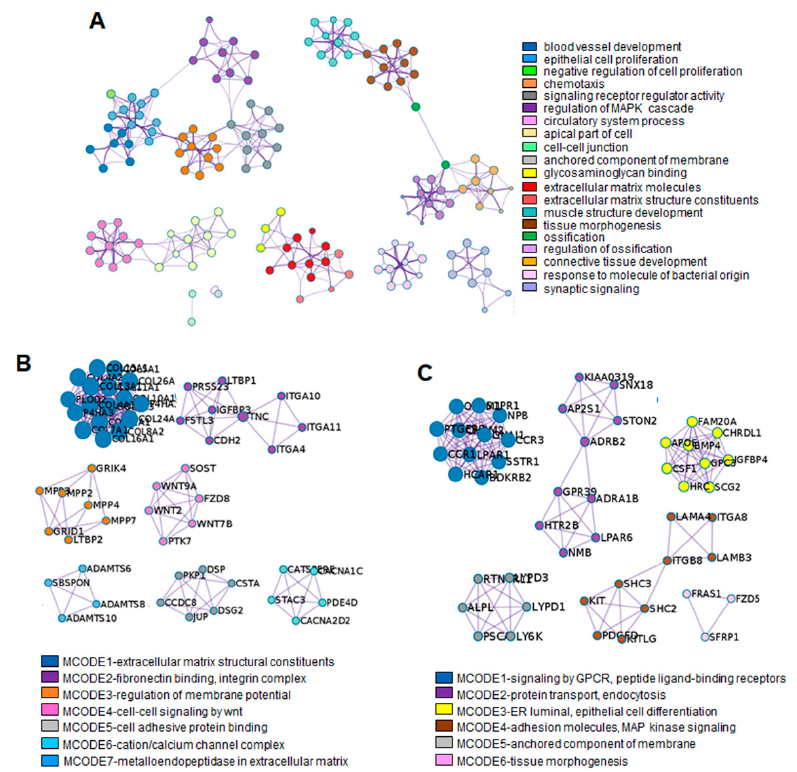
Figure 5. PPI network analysis using Metascape software. ( A ) The enrichment GO clusters including 2245 DEGs. The MCODE algorithm was applied for clustering ontology enrichment to identify neighborhoods. The proteins corresponding with the representative upregulated DEGs in TGF- β 1- treated fibroblastic progenitors ( B ) and in SB+BMP7-treated cementoblastic cells ( C ) were densely connected. Detailed information of the MCODE modules is listed in the Supplementary Table S4. Each term is represented by a circle node, where its size is proportional to the number of input genes falling into that term, and its color represents its cluster identity. Each cluster identity or MCODE network was assigned a unique color.